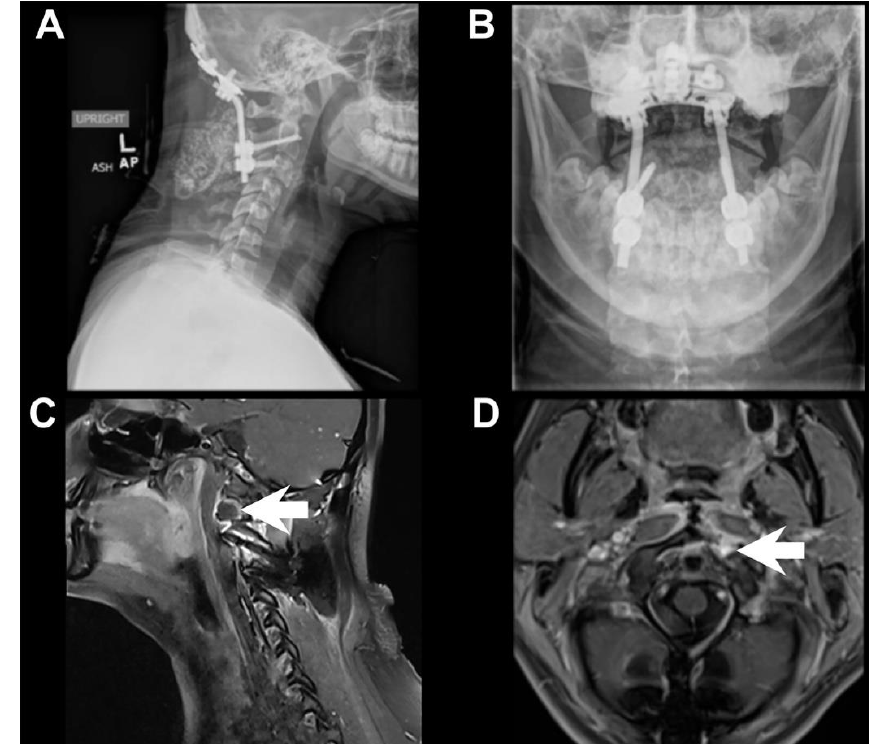
Figure 3. Post-Operative Imaging Studies. Lateral view X-ray of the cervical spine demonstrating hardware on the occiput connected by rods to pedicle screws in C2 and lateral mass screws in C3 bilaterally ( A ). Open mouth odontoid view X-ray demonstrates normal symmetry of C1 and C2 articulation ( B ). Post-contrast MRI T1, sagittal view, demonstrates minimal rim-enhancement within the left lateral C1 representing mild residual tumor (white arrow) ( C ). Post-contrast MRI T1, axial view, of the residual lesion (white arrow) ( D ).